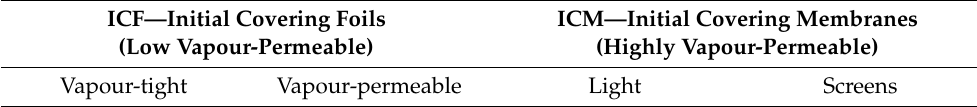
Table 5. Flexible waterproofing products used as initial covering layers [53].